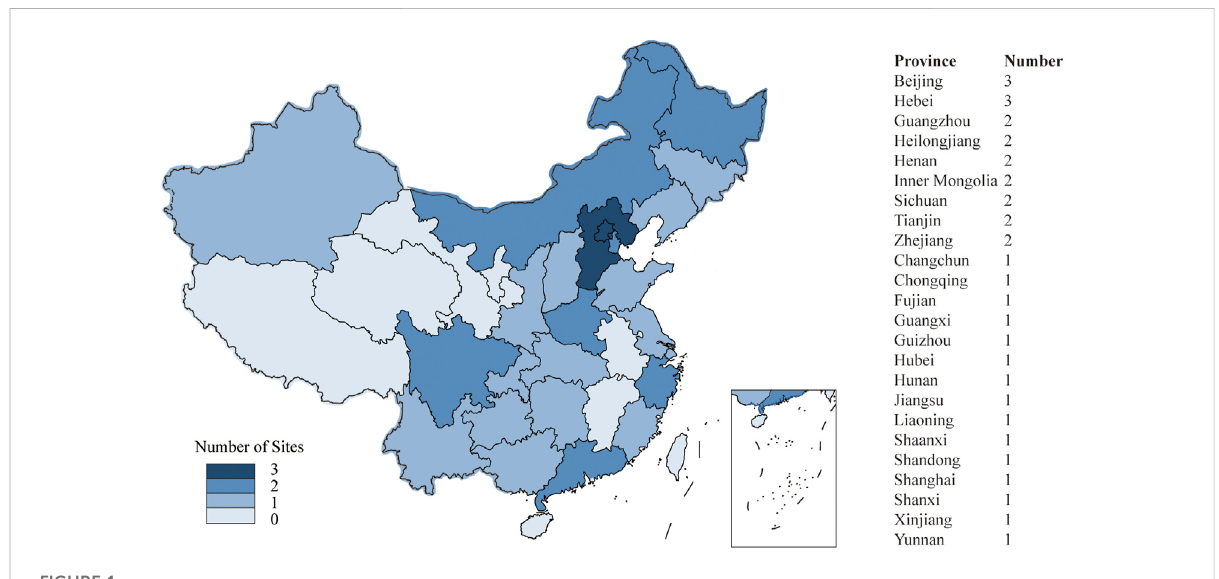
FIGURE 1 Sites distribution of